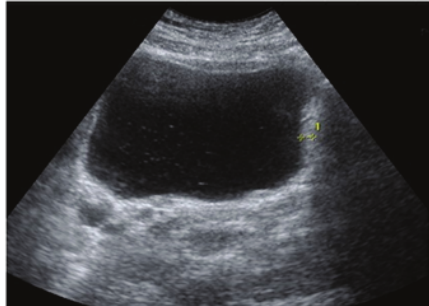
Figure 2: Thickening of the bladder wall and echogenicity in the bladder are